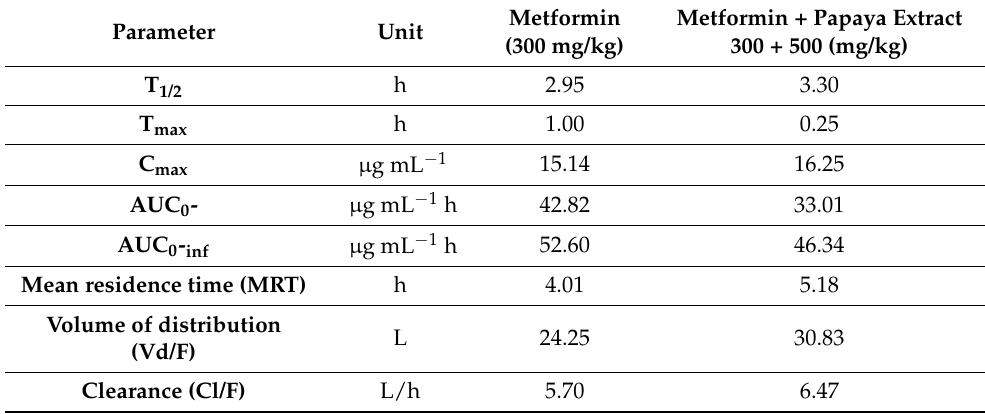
Figure 2. Mean plasma concentration—time curves of metformin after oral administration of 300 mg/kg metformin ( A ) and after oral administration of 300 mg/kg metformin + 500 mg/kg papaya extract ( B ). Table 5. Pharmacokinetic parameters of the developed